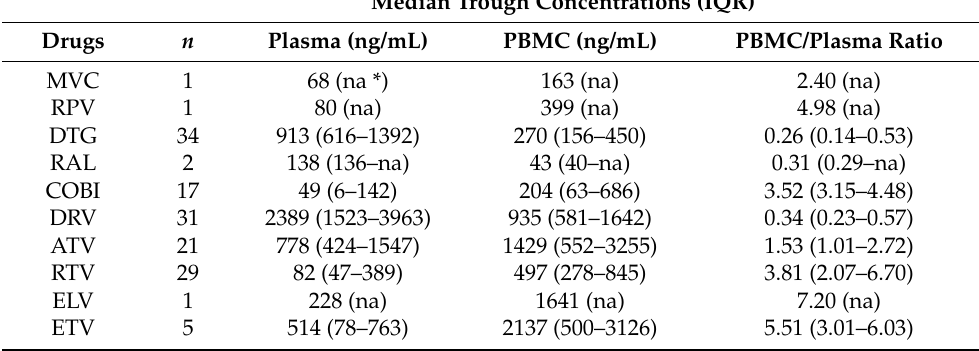
Table 4. Summary of the median observed concentrations in patients’ plasma and PBMC and their relative penetration in